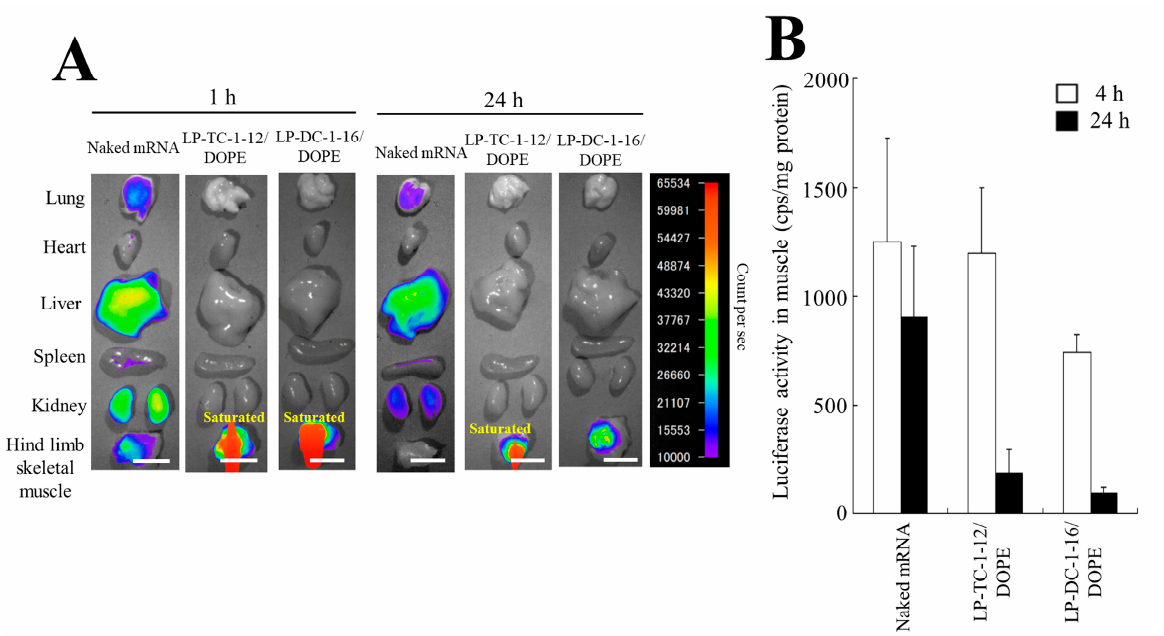
Figure 8. mRNA biodistribution and protein expression in mice after IM injection of mRNA lipoplexes. ( A ) mRNA lipoplexes with 5 µg of Cy5-mRNA were intramuscularly injected into mice. The mice were sacri fi ced 1 or 24 h after injection, and Cy5 fl uorescence images of the tissues were ac- quired with an exposure time of 5 s. Scale bar = 1 cm ( B ) mRNA lipoplexes with 5 µg of FLuc mRNA (5moU) were administered intramuscularly into mice. The mice were sacri fi ced 4 or 24 h after injec- tion, and the luciferase activity of the tissues was measured. Each column represents the mean + S.D. ( n = 4–6).